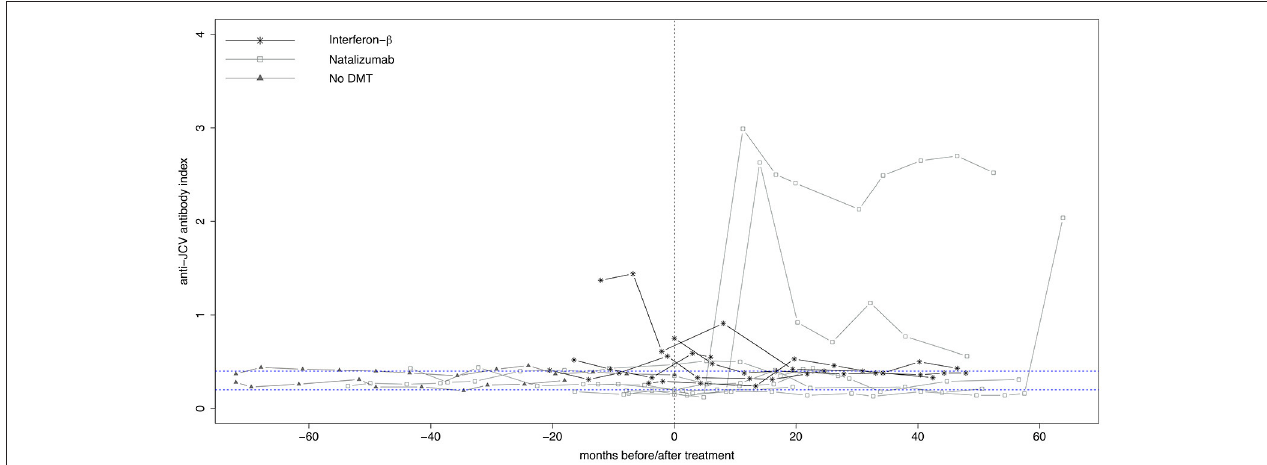
FIGURE 3 | Longitudinal evolution of anti-JCV antibody index in patients with changing anti-JCV antibody status. Serial anti-JCV antibody indices in patients before and after start of interferon- β or natalizumab therapy, as well as in patients without DMT are shown. For building this graph, only patients with changing anti-JCV antibody status (i.e., with either seroconversion or seroreversion) during the observation period were included. Patients without DMT appear per definition left of the vertical dashed line, as in this group no treatment is commenced. Vertical dashed line indicates start of treatment. Upper horizontal dashed line indicates an anti-JCV antibody index of 0.4. Index values > 0.4 are denoted anti-JCV antibody positive. Lower horizontal dashed line indicates an anti-JCV antibody index of 0.2. Index values < 0.2 are denoted anti-JCV antibody negative. Samples with an index ≥ 0.20 but ≤ 0.40 (intermediate response) are classified as anti-JCV antibody positive or negative based on confirmation test (second step of the enzyme-linked immunosorbent assay), i.e., the displayed index values within this range might be classified as positive or negative. For further details see (3, 8). DMT, disease-modifying treatment; JCV, John Cunningham